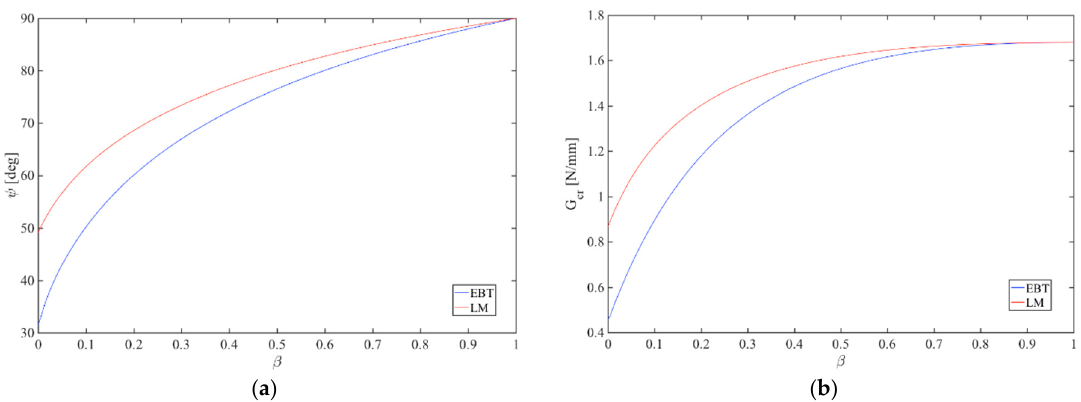
ψ ψ ; ( b ) Critical energy ; ( b ) Critical energy